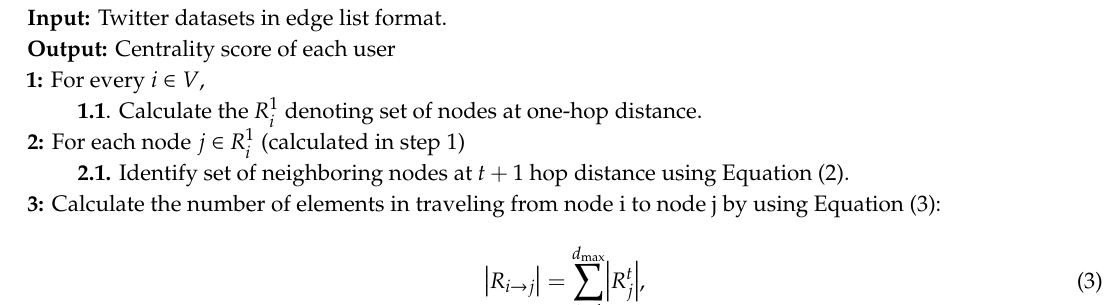
Algorithm 1 Distributed Calculation for Degree and Closeness Centrality